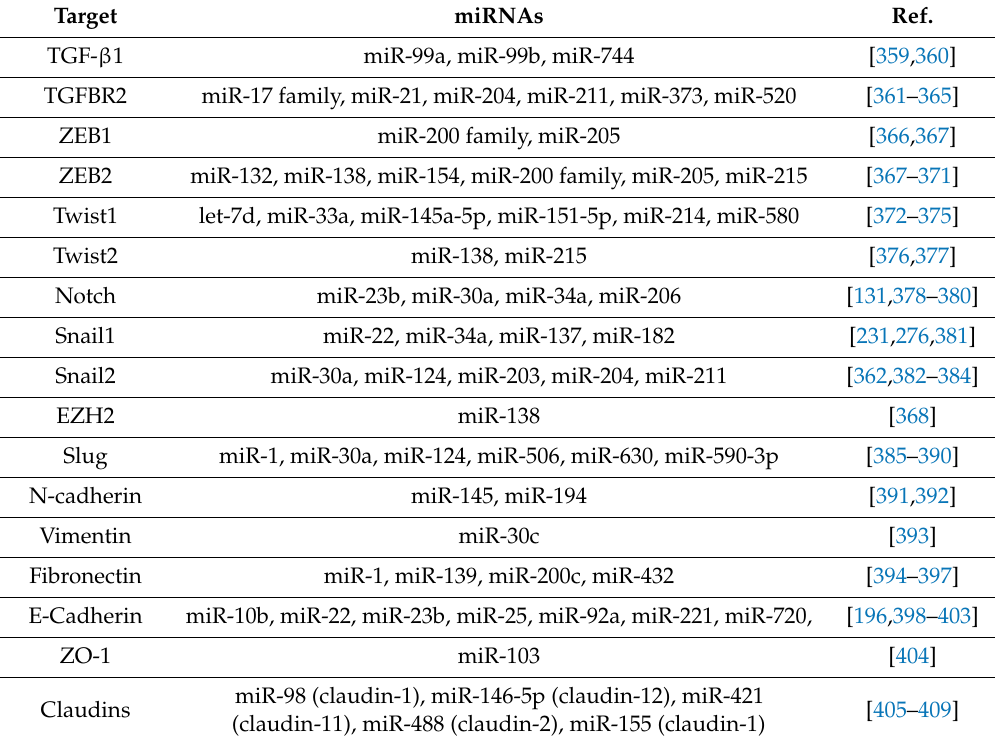
Table 6. Direct regulation of EMT signaling by